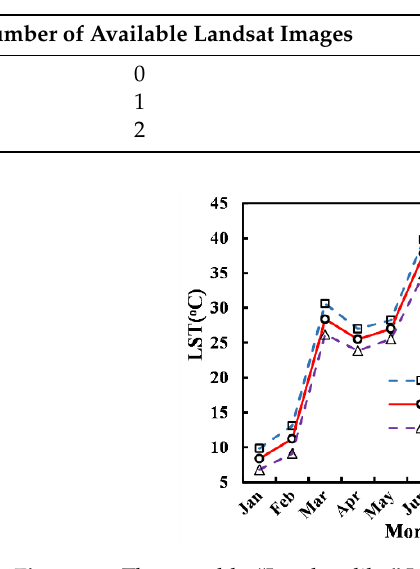
Figure 15. The monthly “Landsat-like” LSTs with 75%, 50%, and 25% percentiles.